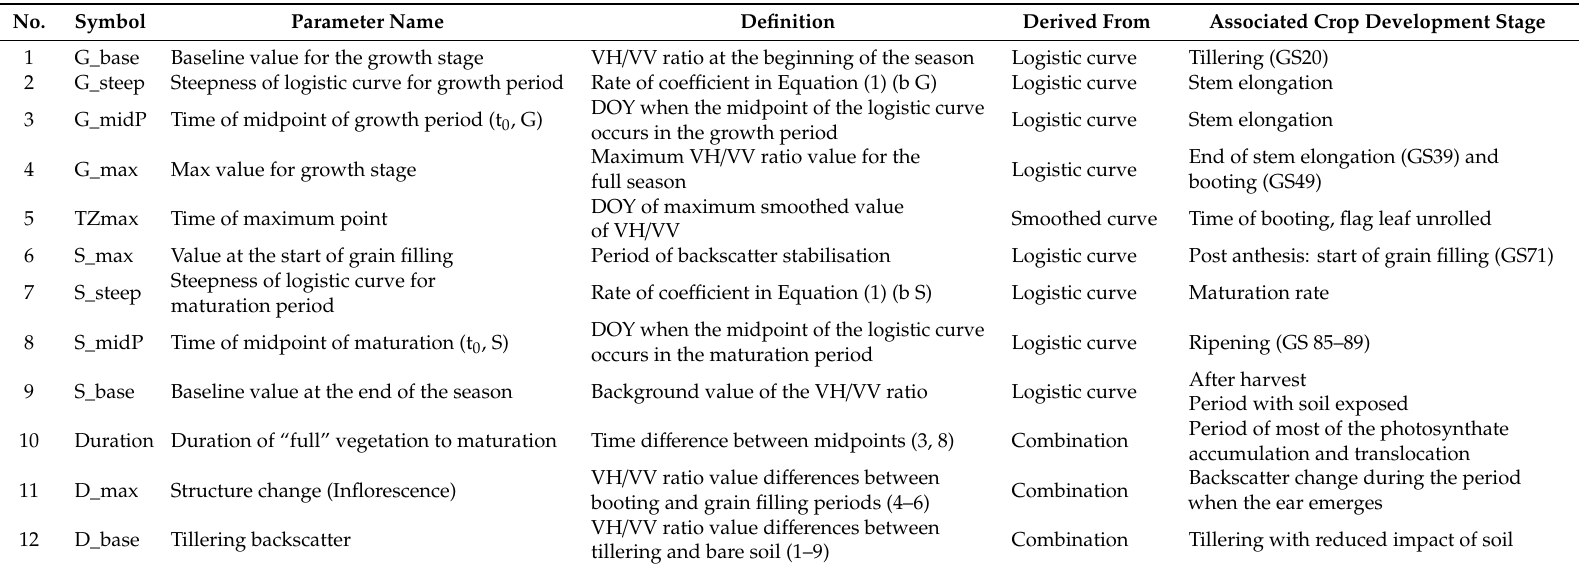
Table 2. Definitions of the VH / VV ratio curve parameters and the anticipated associated crop development stage (Biologische Bundesanstalt, Bundessortenamt und CHemische Industrie - BBCH or Zadoks